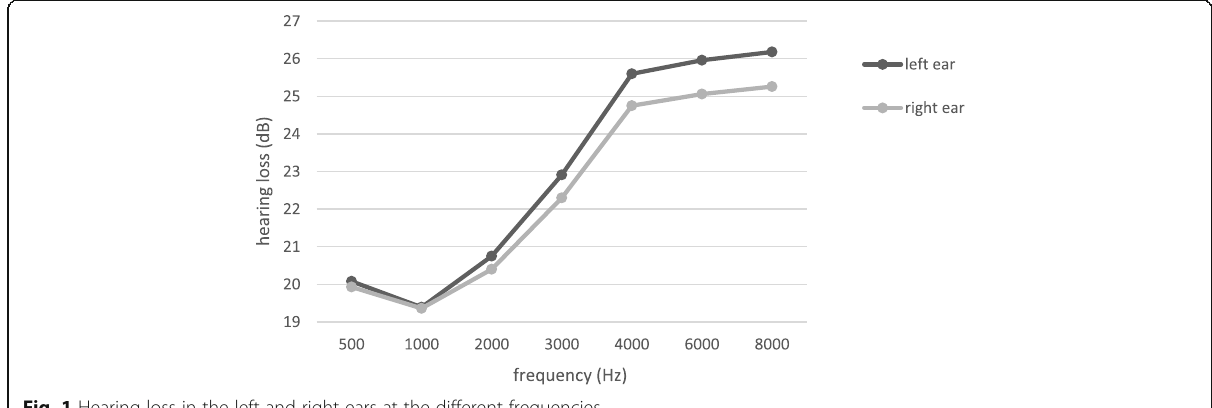
Fig. 1 Hearing loss in the left and right ears at the different